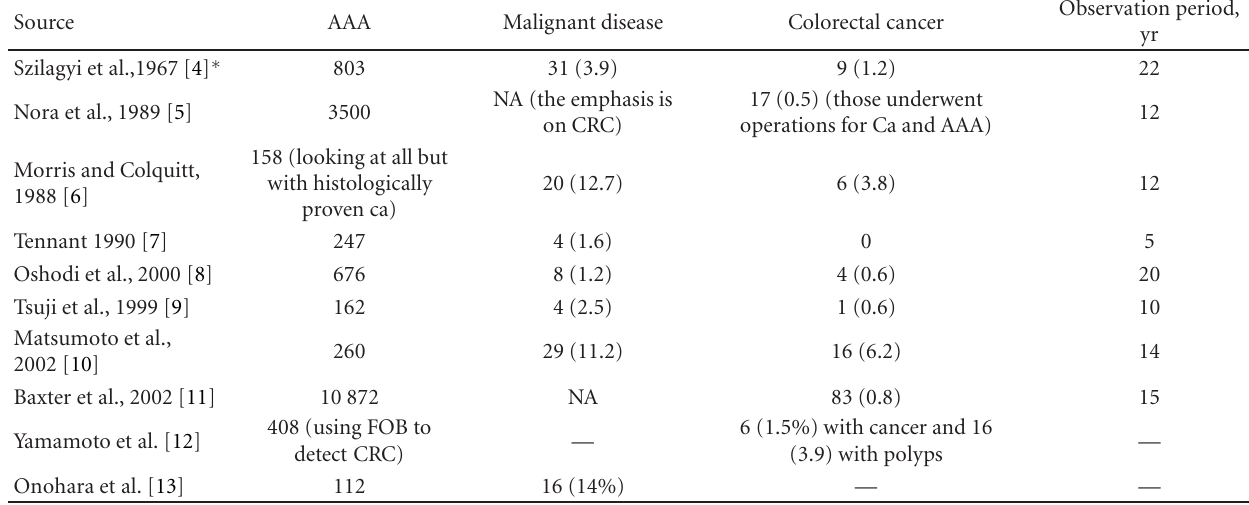
Table 1: Prevalence of aortic aneurysm and concomitant malignancy.